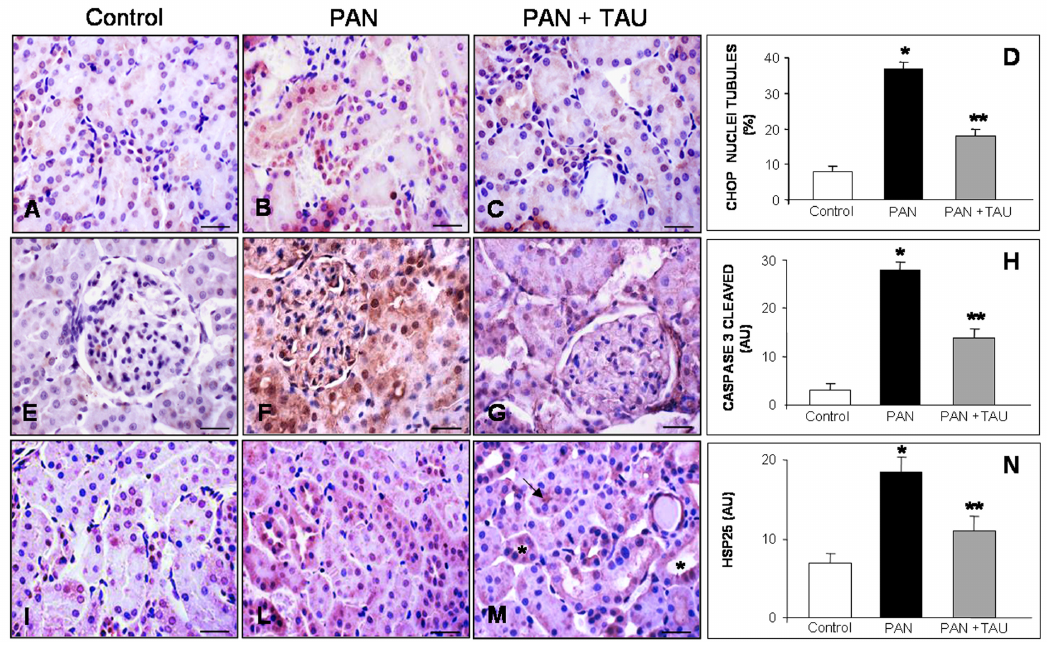
Figure 4. Proximal tubular apoptosis. ( A – C ) CHOP, ( E – G ) activated caspase 3, ( I – M ) HSP25 in ( A , E , I ) control rats, and ( B , F , L ) PAN nephrotic rats that decreased with oral TAU pre-treatment ( C , G , M ). ( M ): the arrow shows the brush border positivity at proximal tubule level and the asterisks identify the positivity in the distal tubules. Bar represents 20 µm. Quantitative analysis of immunostaining for ( D ) CHOP, ( H ) expressed as nuclear positive percentage, and ( N ) for caspase 3 cleaved and HSP25, expressed as arbitrary units. * p < 0.05 statistically significant versus control group; ** p < 0.05 significant versus PAN group.